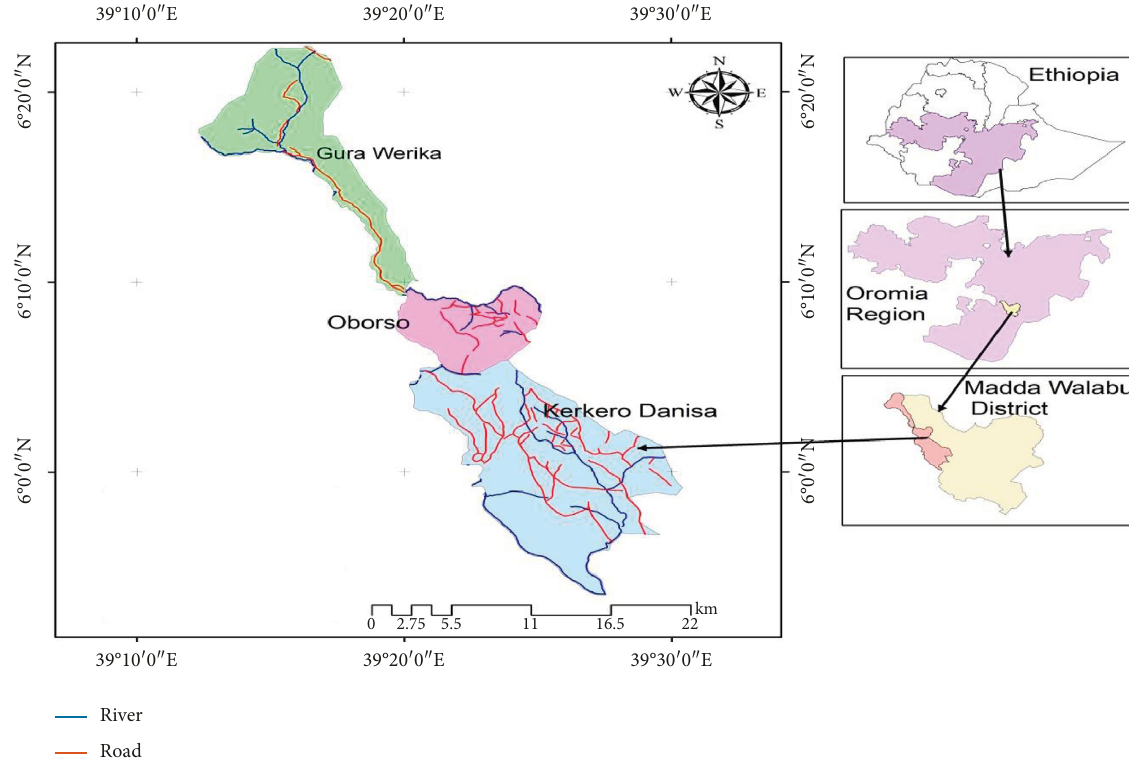
Figure 1: Map of the study